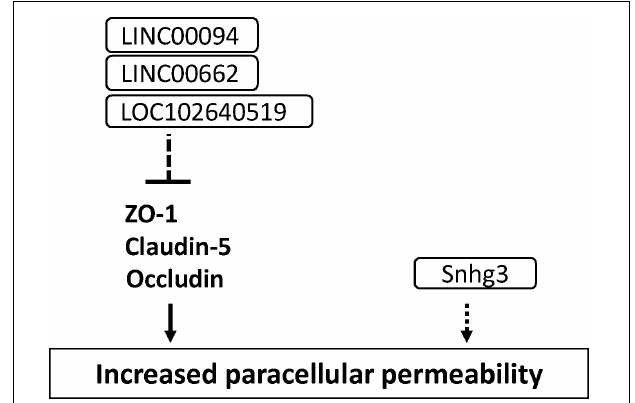
FIGURE 8 | Long non-coding RNAs involved in the down-regulation of tight junction protein levels and BBB function in BMECs. Dashed line indicates indirect down-regulation by lncRNAs. Dashed arrow indicates unknown mechanisms.